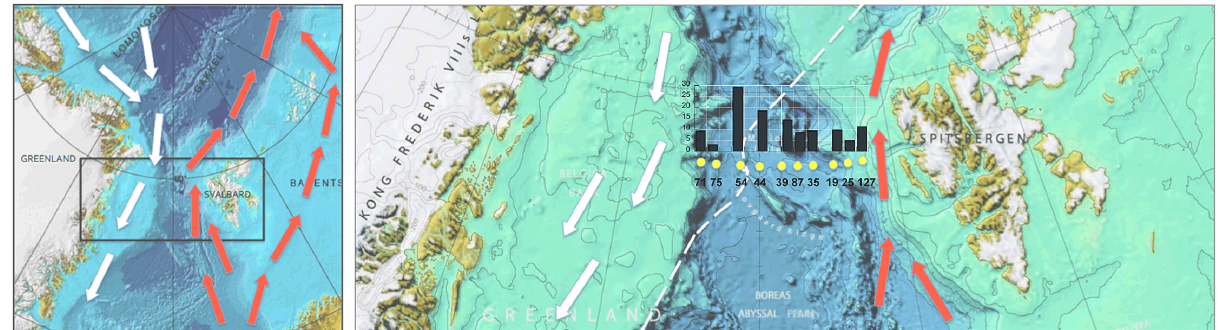
Figure 1. Map and schematic surface ocean circulation of the study area (red arrows: West Spitsbergen Current, white arrows: East Greenland Current). The enlarged part shows the sampled stations (yellow dots). Bars represent absolute abundances (indm − 3 water) of planktic foraminifera in the upper 500m of the water column along the transect at 78 ◦ 50 (cid:48) N across the Fram Strait. The white dashed line shows the position of the sea-ice margin at the position of the transect during the sampling period (shipboard observation and satellite data from the US National Oceanic and Atmospheric Administration). Map source: International Bathymetric Chart of the Southern Ocean (Jakobsson et al.,